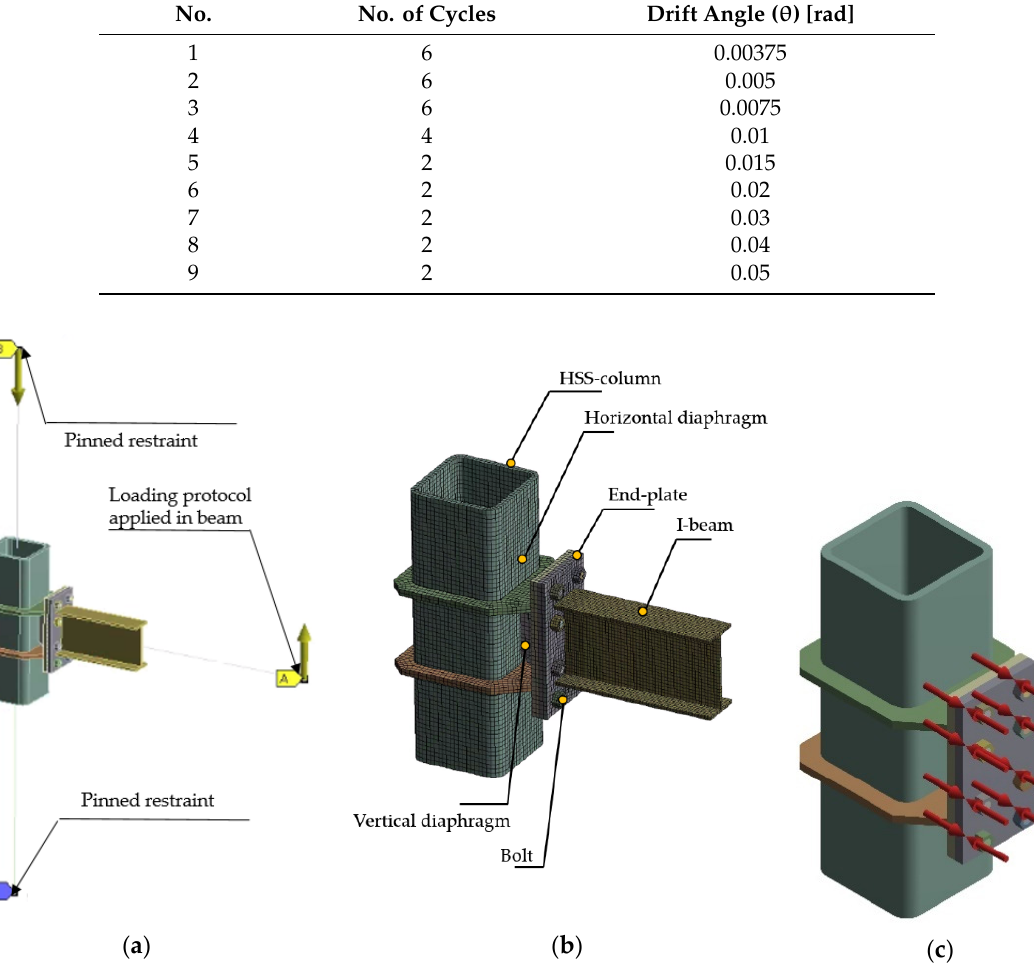
Figure 5. ( a ) Boundary conditions, ( b ) elements in EP-HSS connection and ( c ) bolt pretension in Finite Element (FE) model. Table 2. Load protocol in Finite Element (FE) models, adapted from [14]